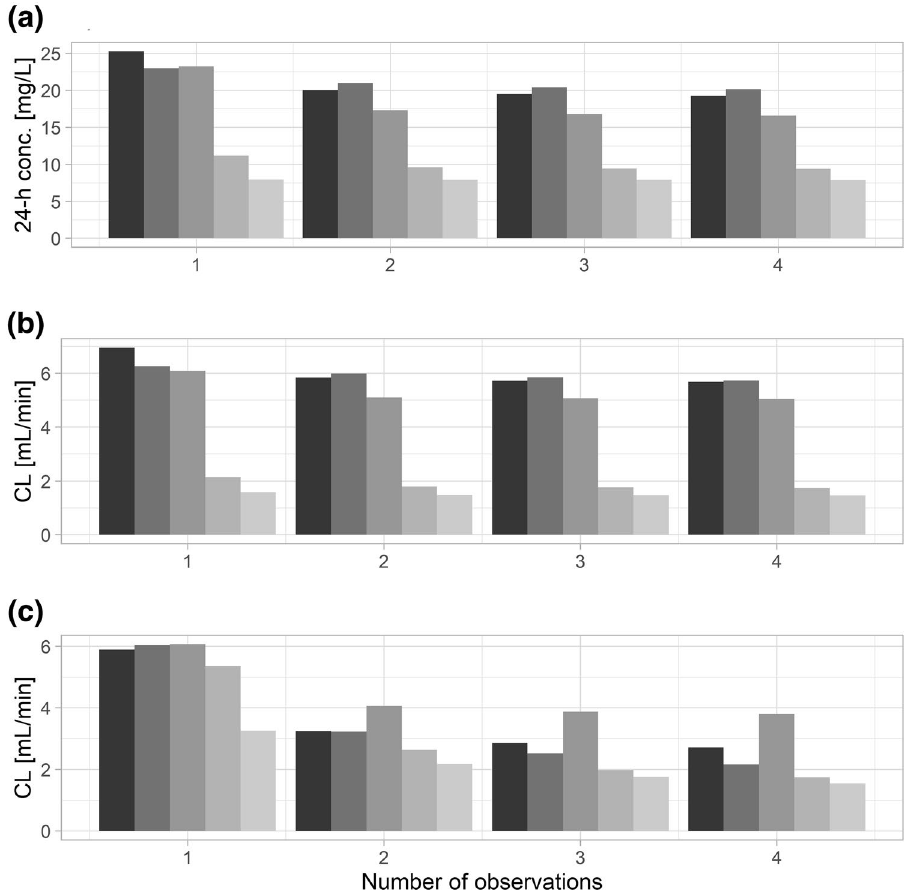
Figure 4. RMSE concerning predicted versus observed iohexol concentrations 1440 min post injection ( a ) and concerning clearance (CL) based on observed data ( b ) and stochastic simulations ( c ). Different shades of gray represent the full two-compartment, reduced two-compartment, full three-compartment, reduced three- compartment, and the reduced three-compartment model with covariates (from left to right/black to light gray).